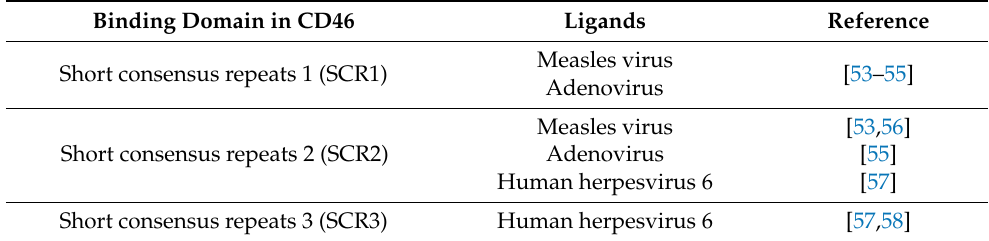
Table 1. Pathogens binding to